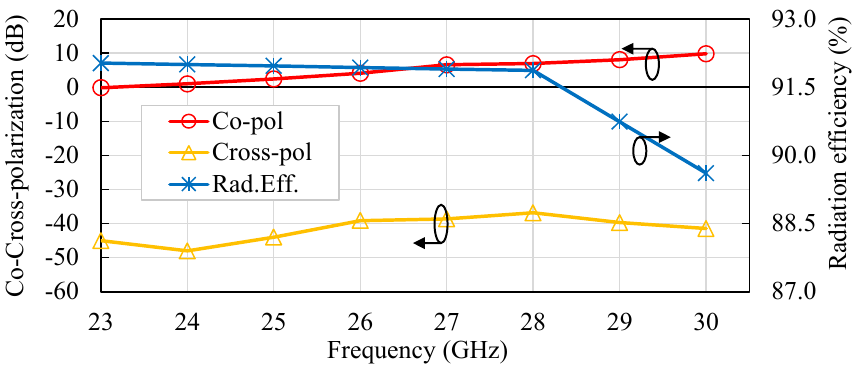
Figure 13. Co-polarization, cross-polarization, and radiation efficiency over the bandwidth of operation.